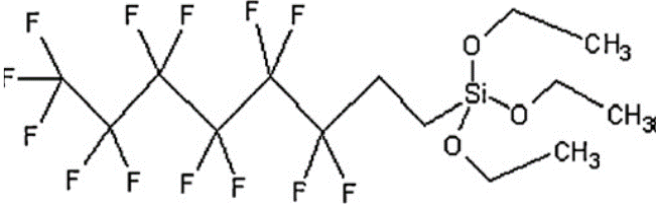
Figure 1. Molecular structure of 1H, 1H, 2H, 2H-perfluorooctyltriethoxysilane (PFOTS)